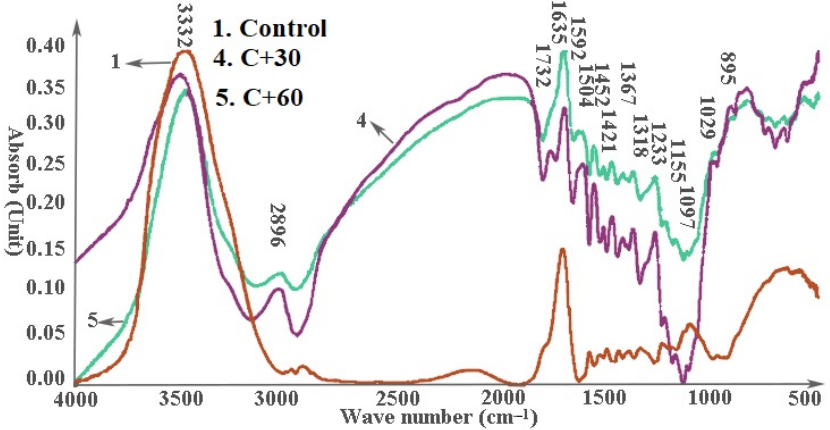
Figure 7. Effect of Cellulase pretreatment on FTIR spectra of a 70:30 wood/hemp hurd fiber mixture.